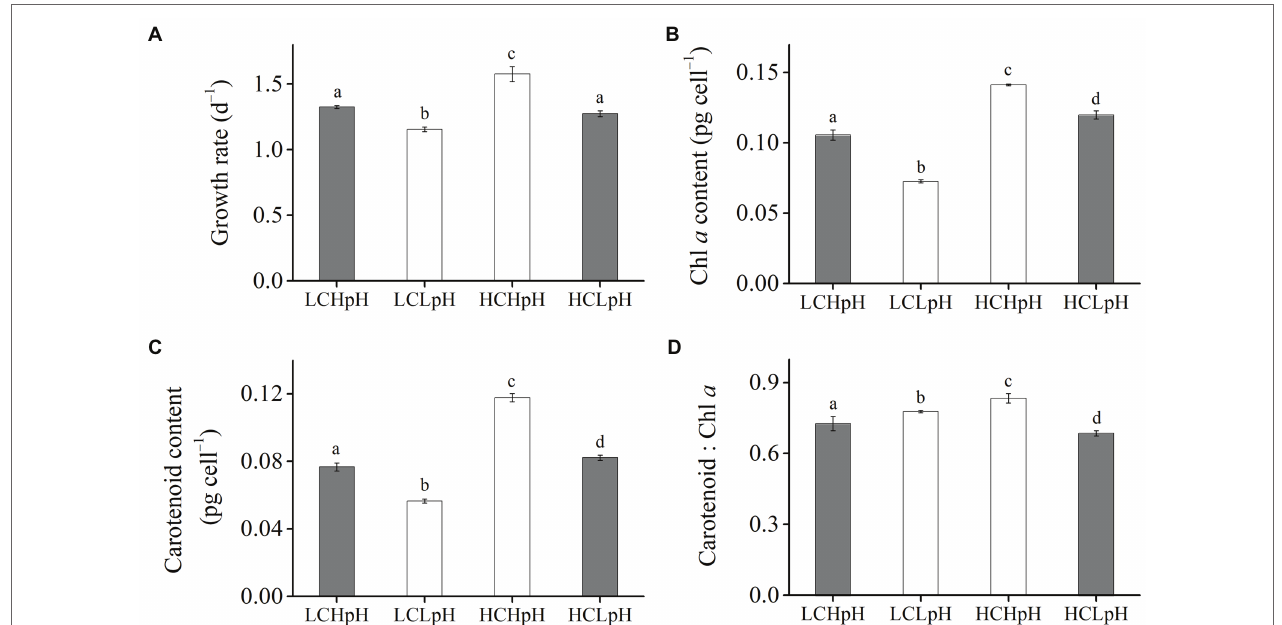
FIGURE 1 | (A) Growth rate, (B) chlorophyll a (Chl a ) content, (C) carotenoid content and (D) carotenoid: Chl a ratio of Emiliania huxleyi RCC1266 under present DIC concentration and high pH value (LCHpH, gray), low DIC concentration and low pH value (LCLpH, reduced pH), high DIC concentration and high pH value (HCHpH, ocean carbonation), and high DIC concentration and low pH value (HCLpH, ocean acidification, gray) treatments. Data were obtained after cells were acclimated to experimental conditions for at least 13 generations and means ± standard deviation (SD) of 4 replicate populations. Different letters (a, b, c, d) in each panel represent significant differences between four treatments (Tukey Post hoc , p <